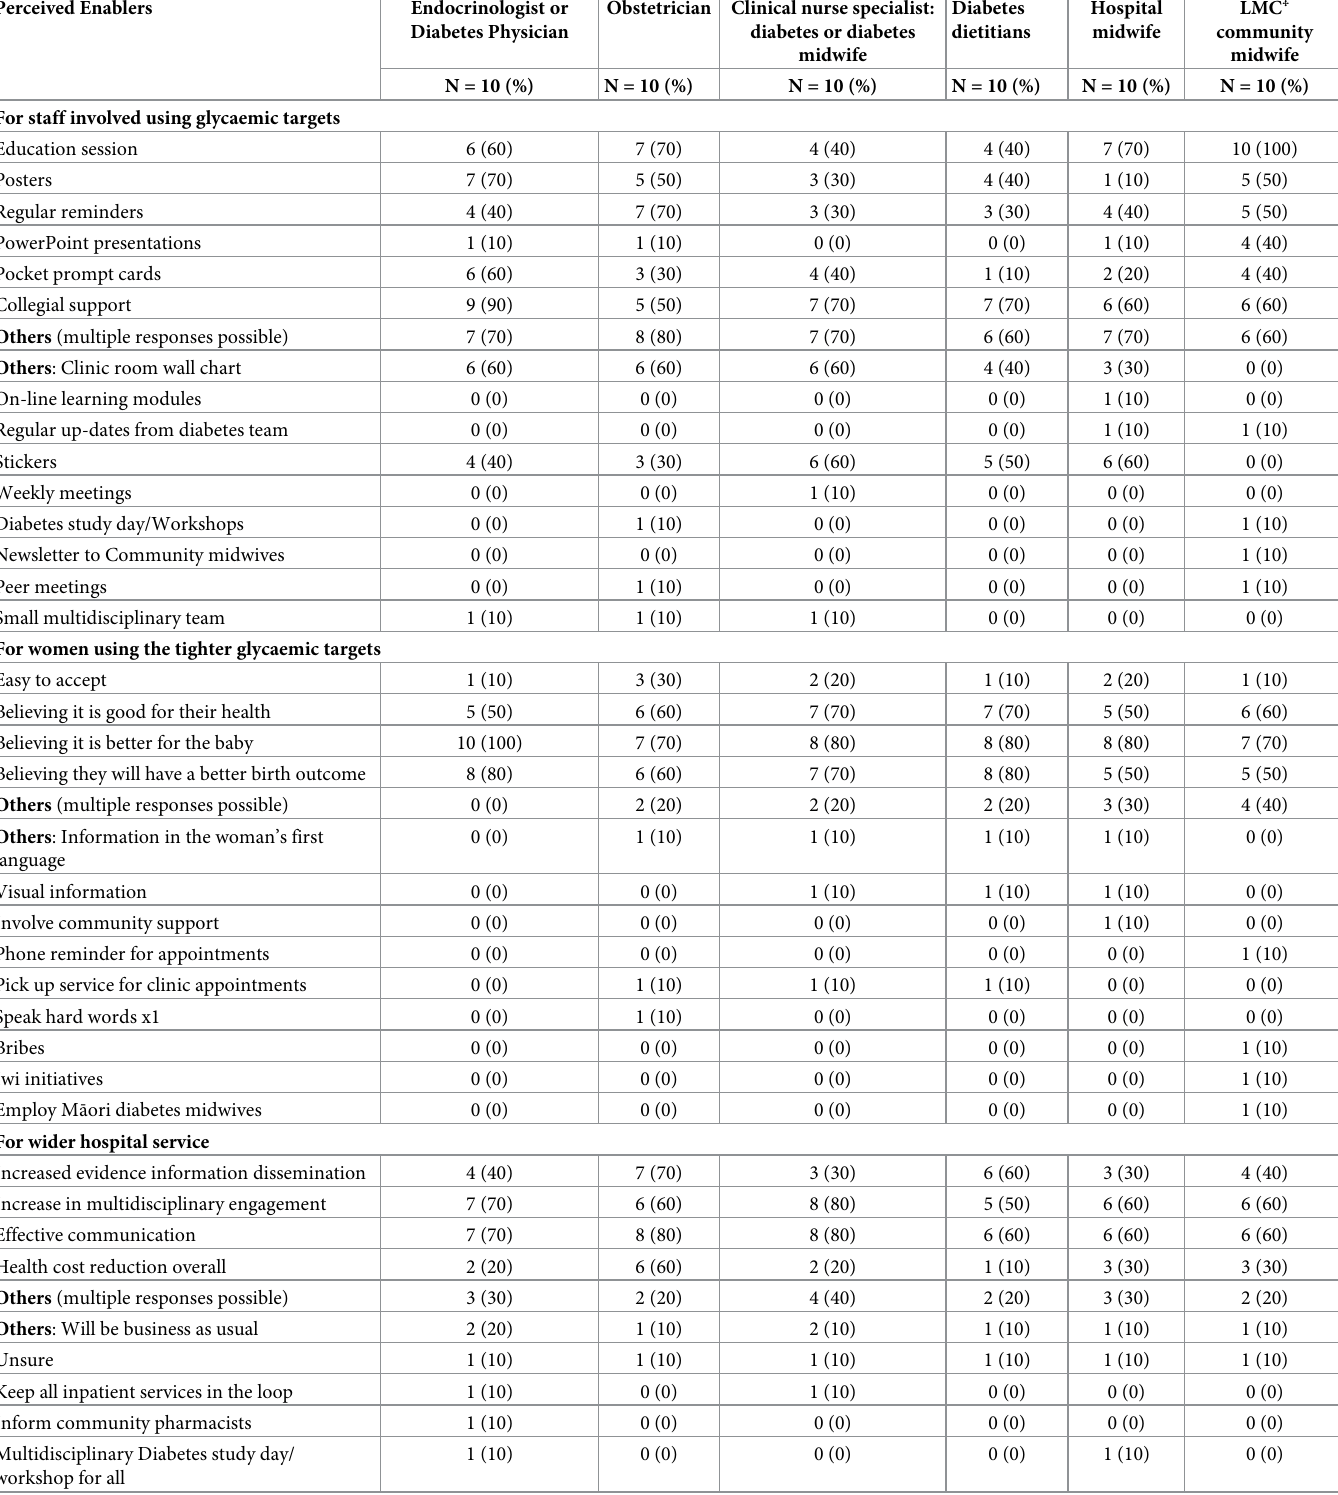
Table 4. Perceived enablers prior to implementing tighter glycaemic targets by Key Informant Health Professionals #